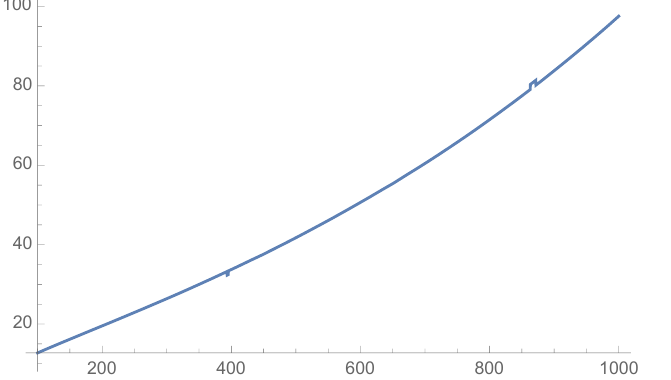
Figure 5 . Ratio of the gluon luminosity in pp collisions at CM energies 100 TeV to that at 14 TeV as a function of parton CM energy